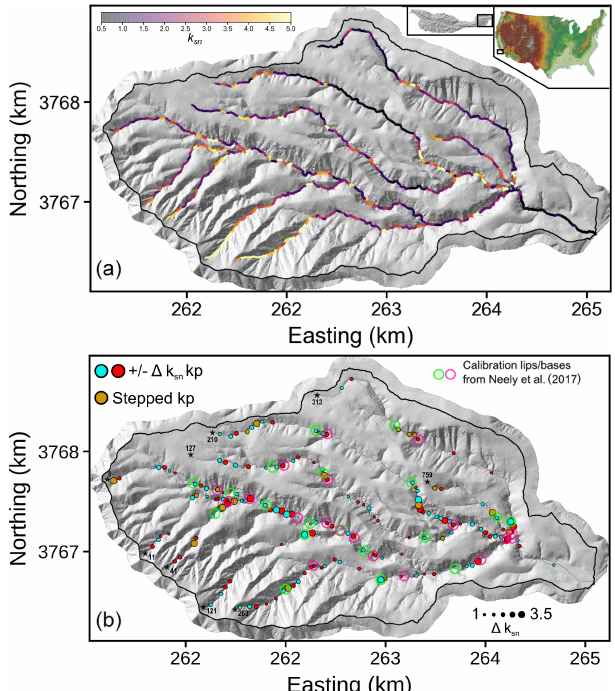
Figure 6. The test location on Santa Cruz Island, CA, USA. (a) Map of channel network extracted with the Pelletier method (Pelletier, 2013) and coloured by k sn value calculated with Mudd et al. (2014). (b) Extracted knickpoints plotted after thinning the dataset as described in Sect. 4.1. The purple and green circles re- spectively represent the calibration knickzone bases and lips with the 50m radius used for assessing algorithm performances. Stars and associated numbers are source numbers, which can be com- pared to Fig. 7. Topographic data are 1m precision lidar DEM (see Supplement Sect. S1 for metadata) reprojected in WGS84 UTM zone